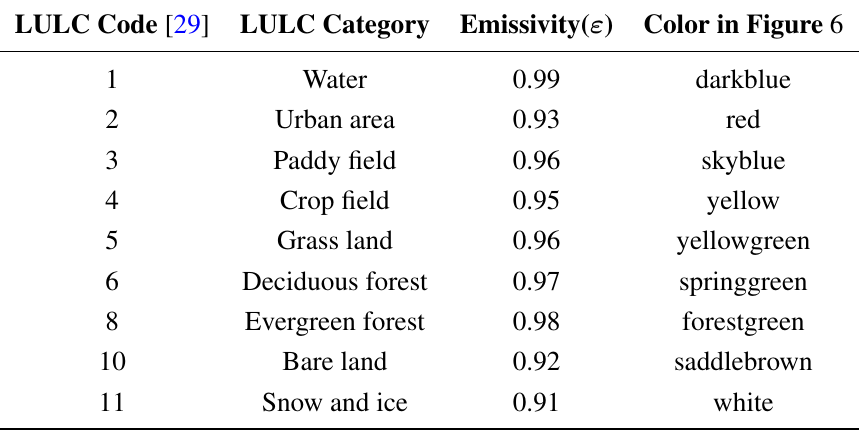
Table 2. Emissivity assigned by land use and land cover data (Figure